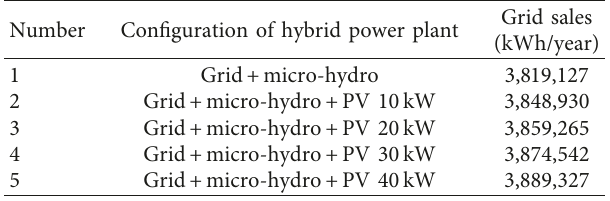
Figure 19: Total capital costs for various configurations of the hybrid solar photovoltaic and micro-hydro systems. Table 4: Grid sales for various configurations of the hybrid power plant